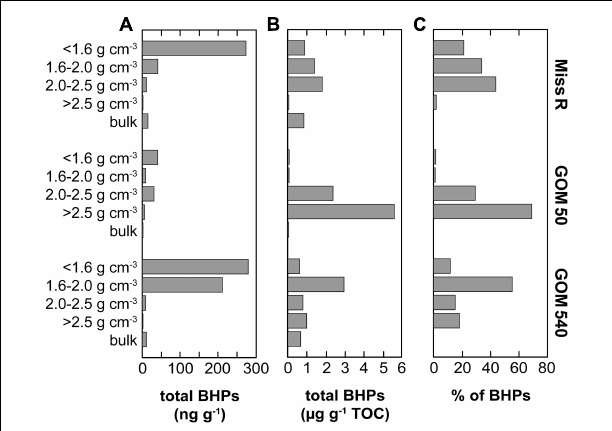
FIGURE 4 | Abundance of BHPs in density fractions and bulk sediment samples along the Miss R – GOM transect. (A) Mass-normalized absolute BHP abundance and (B) TOC-normalized absolute BHP abundance calculated based on the data of Wakeham et al. (2009). (C) Relative abundance of BHPs among density